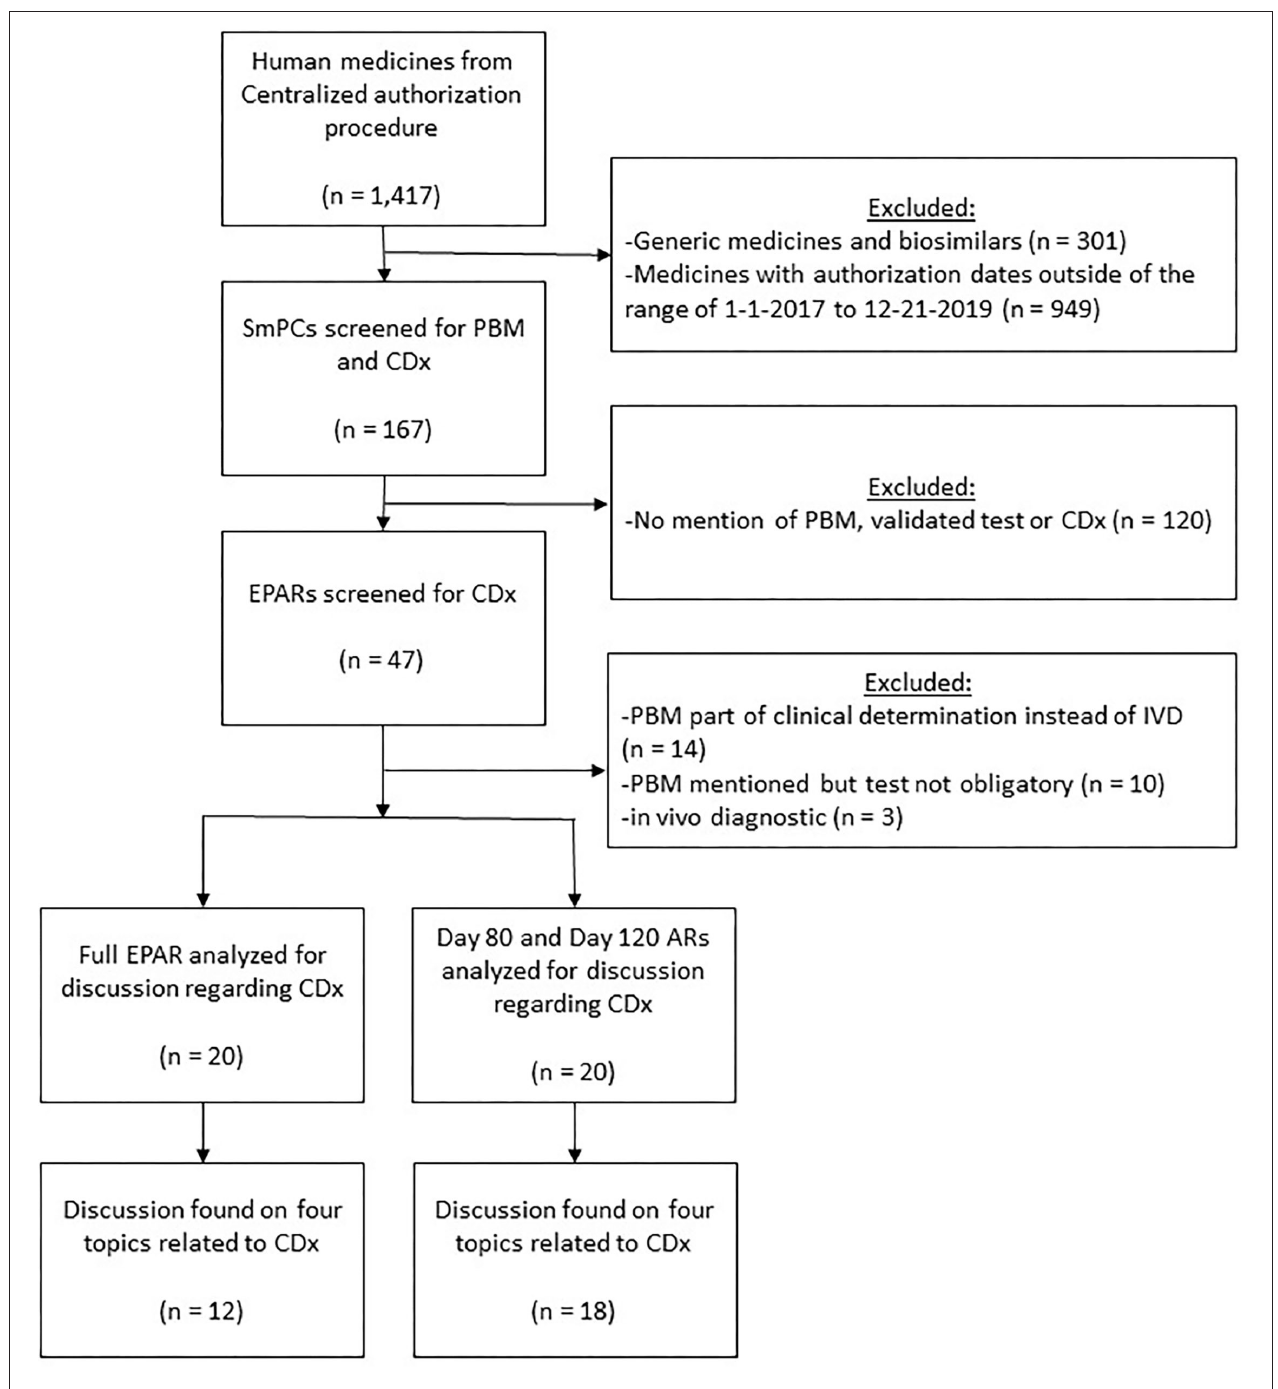
FIGURE 2 | Flowchart visualizing the selection of medicines with CDx involved that were registered by EMA in January 2017–December 2019. AR, assessment report; CDx, companion diagnostics; EPAR, European public assessment report; PBM, predictive biomarker; Q&A, question and answer; SA, scientific advice; SmPC, summary of product